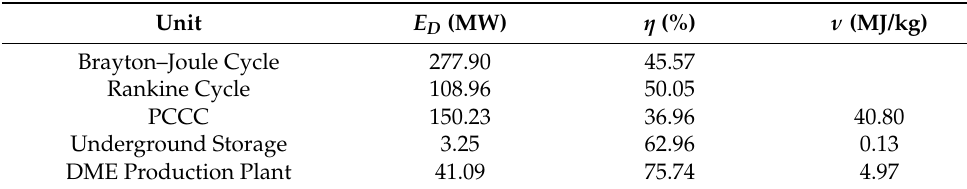
Table 7. Exergy analysis results.